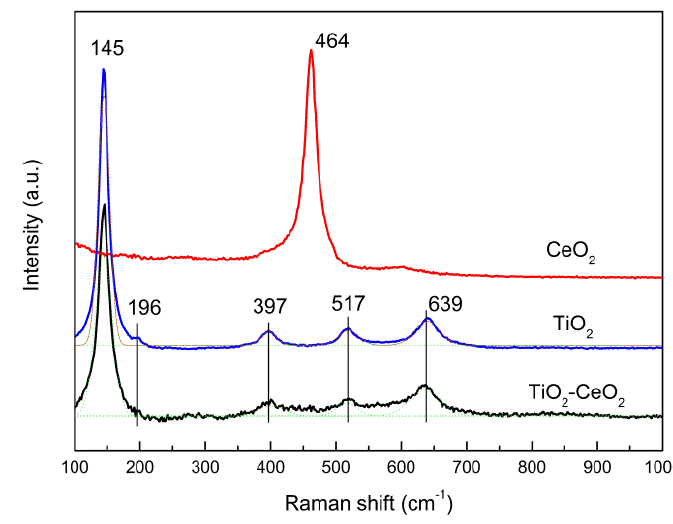
Figure 4. Raman spectra of the CeO 2 , TiO 2 and TiO 2 -CeO 2 catalysts.